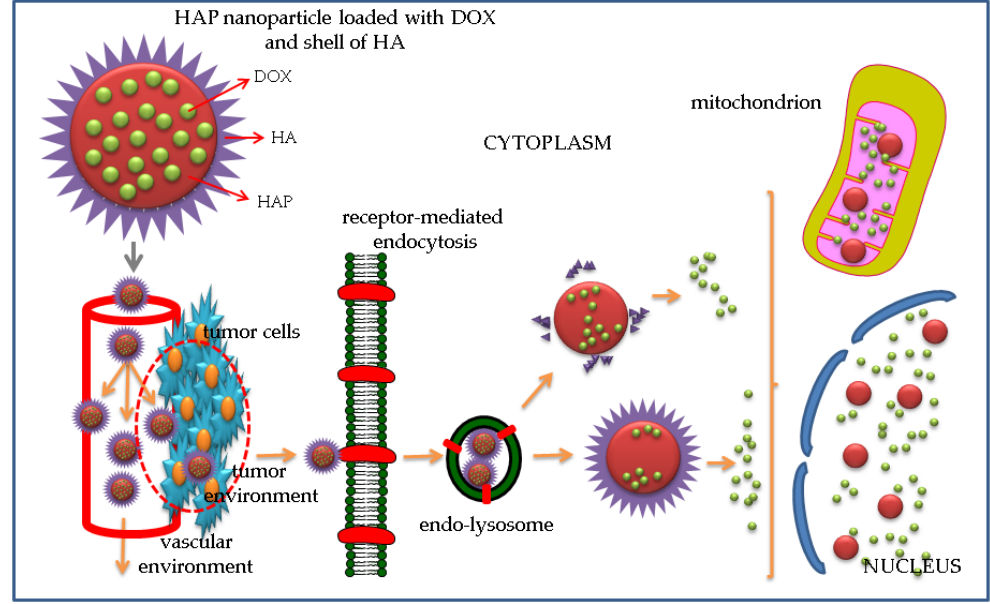
Figure 15. Scheme showing the targeted antitumor mechanism of HAP-HA nanoparticles loaded with DOX. Mechanism of drug delivery into the cell nuclei and mitochondria. Adapted from [168], Elsevier, 2016.